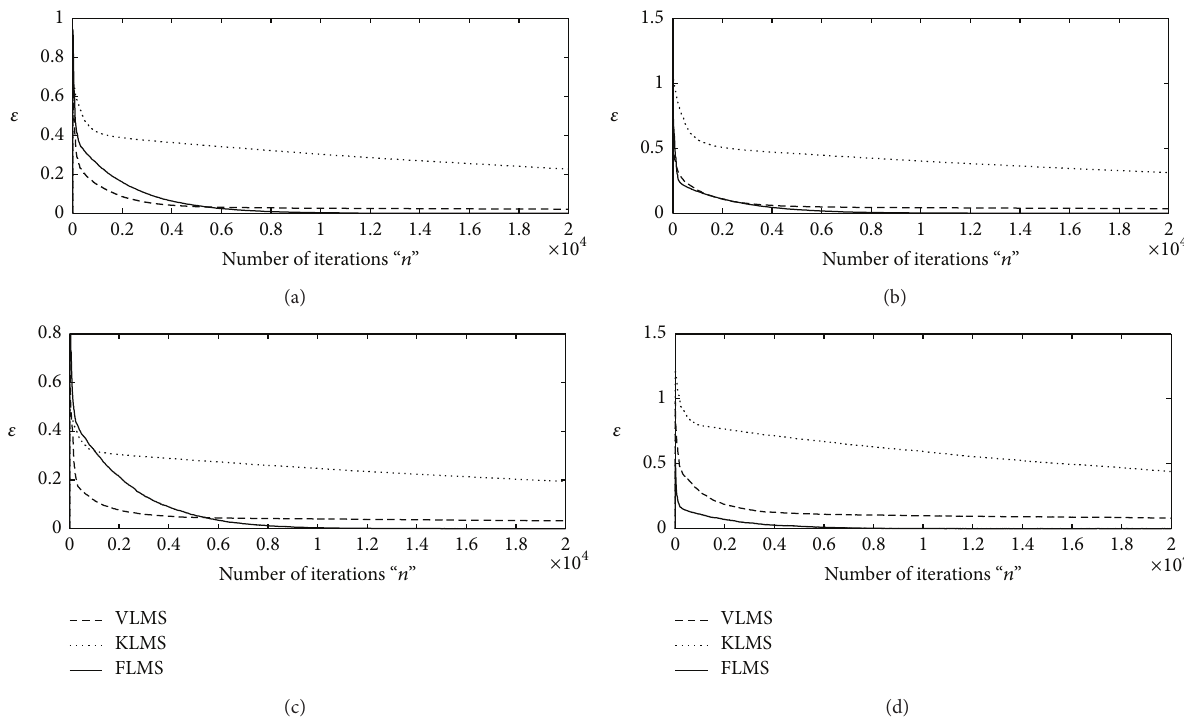
Figure 5: Iterative adaptation of merit function by VLMS, KLMS, and FLMS for fr = 0.5 algorithms for 𝜇 ∈ (10 −03 , 10 −05 ) (a) for SNR = 30 dB, (b) for SNR = 20dB, (c) for SNR = 10, and (d) for SNR = 3dB. Table 5: Comparison of proposed results against true values of INCAR model for 30dB SNR.